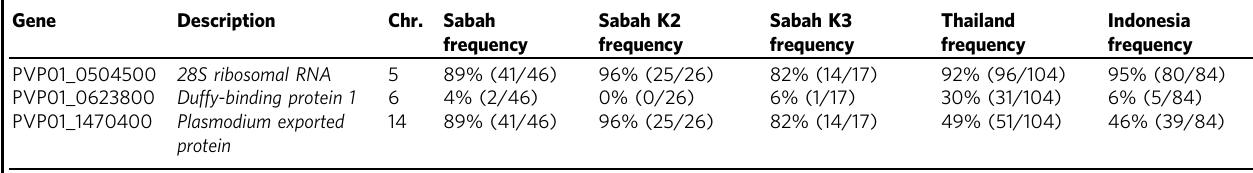
Twenty-two samples with an excess of CNVs (18 + ) were excluded from the analysis